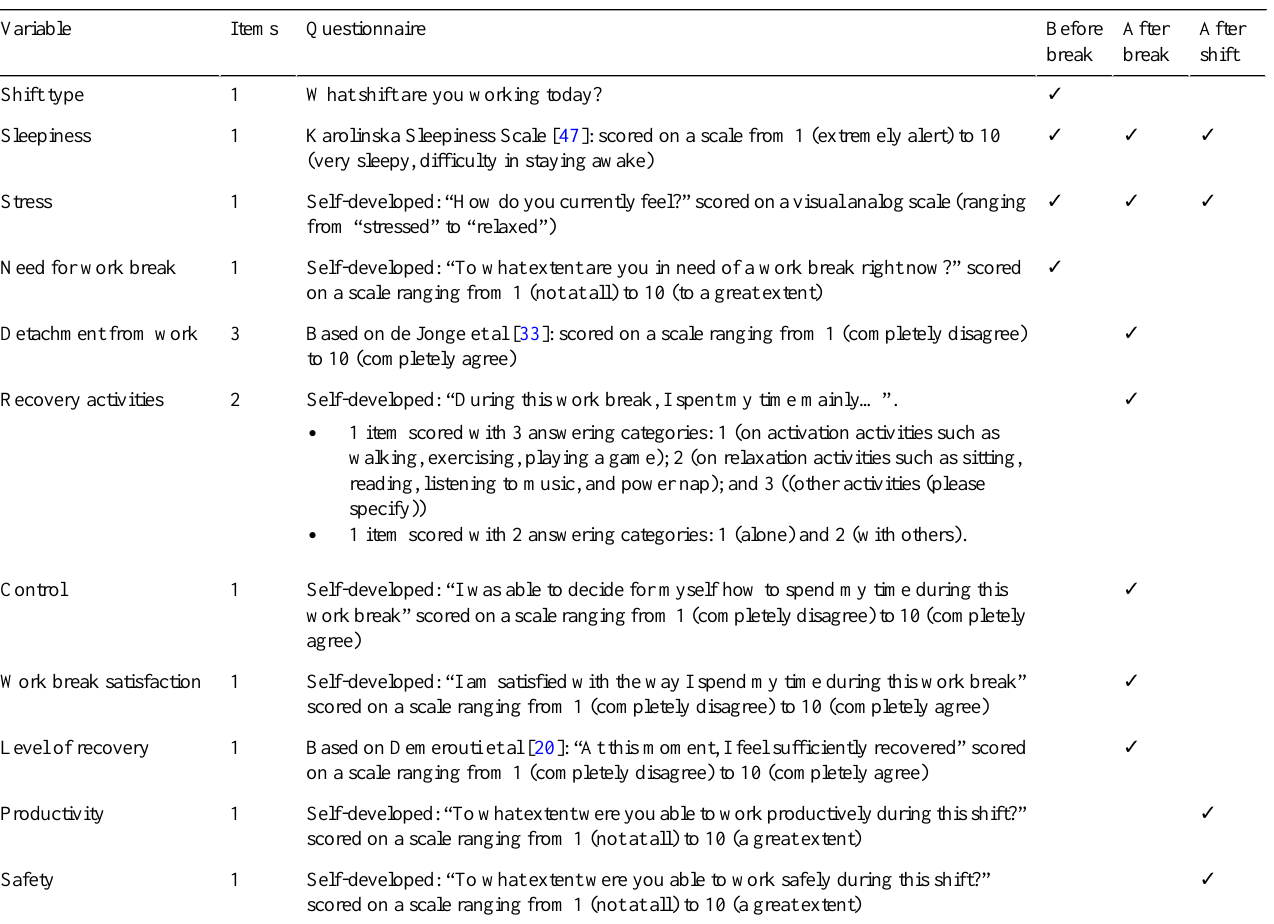
Table 1. Variables retrieved through EMA.